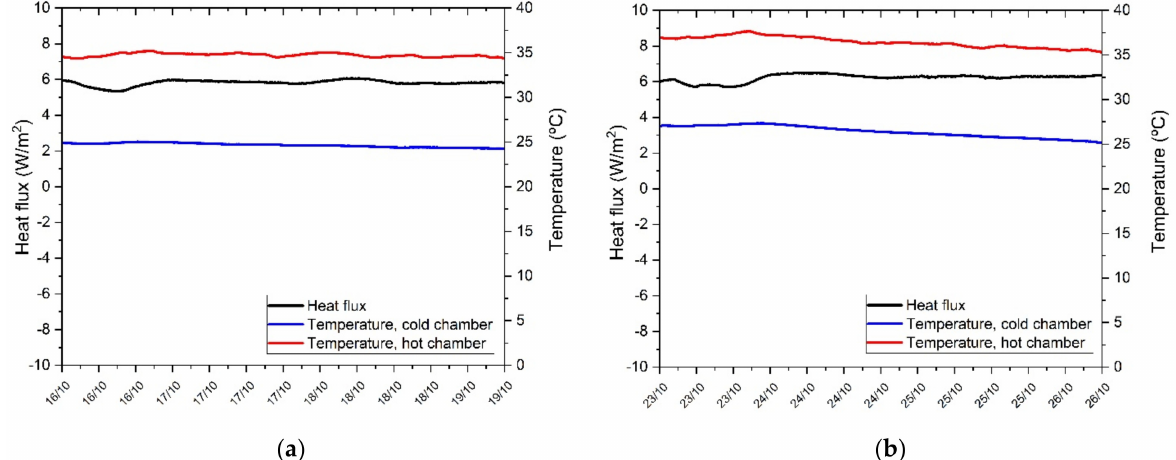
Figure 12. Measurements of the heat flux and hot and cold superficial temperatures in the set: ( a ) panel reed G1 and MDF; ( b ) panel reed G2 and